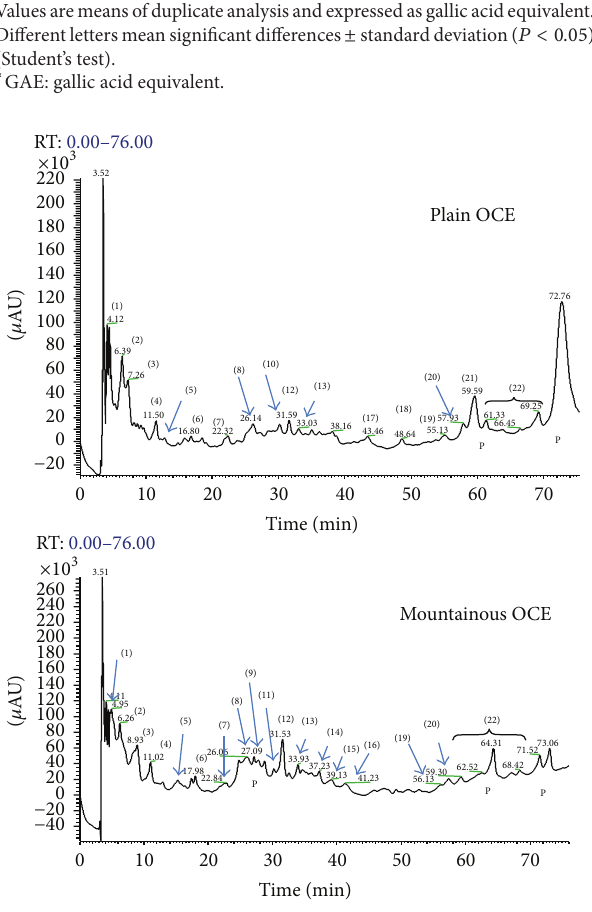
Figure 1: HPLC chromatograms of the phenolic profile of OCE. Peaks identities: (1) hydroxytyrosol glucoside, (2) hydroxytyrosol, (3) tyrosol, (4) vanillic acid, (5) sinapic acid, (6) syringic acid, (7) caffeic acid, (8) elenolic acid, (9) oleuropein aglycone, (10) verbascoside, (11) rutin, (12) luteolin, (13) quercetin, (14) luteolin- 7-rutinoside, (15) luteolin-7-glucoside, (16) apigenin, (17) methoxy- luteolin, (18) naringenin (19) ligstroside aglycon, (20) ligstroside, (21) oleuropein, (22) secoiridoids derivatives and (P) polymeric